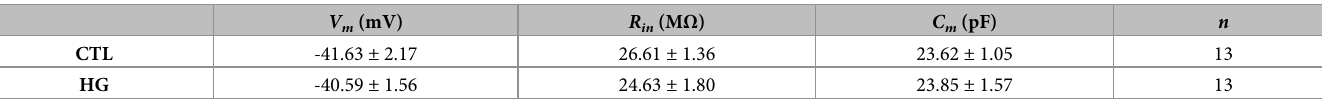
Table summarizes the membrane potential ( V RAGE KO mice maintained in either control or high glucose conditions. Means were compared by unpaired t -test, no significant differences were found between the